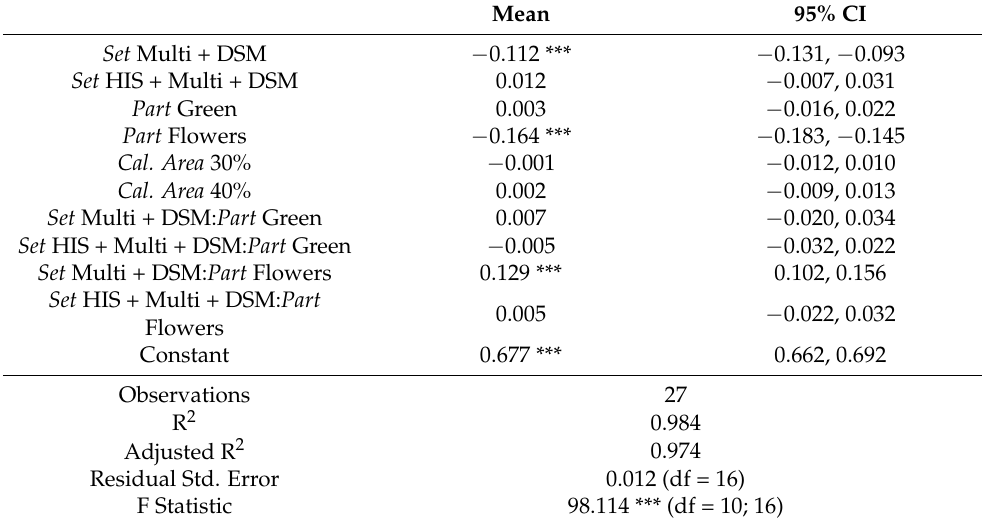
Table 1. Results of the linear model using balanced accuracy (BA) as the response variable and the dataset factors of variable ( Set ), plant part ( Part ) and percentage of calibration area ( Cal. Area ) as covariates. Values are reported as mean estimate and 95% confidence interval. Only the interactions between the factors that were found to significantly affect BA are shown. The reference levels are HIS + DSM for Set , Total for Part and 30% for Cal. Area . Significance is reported as *** p < 0.001.